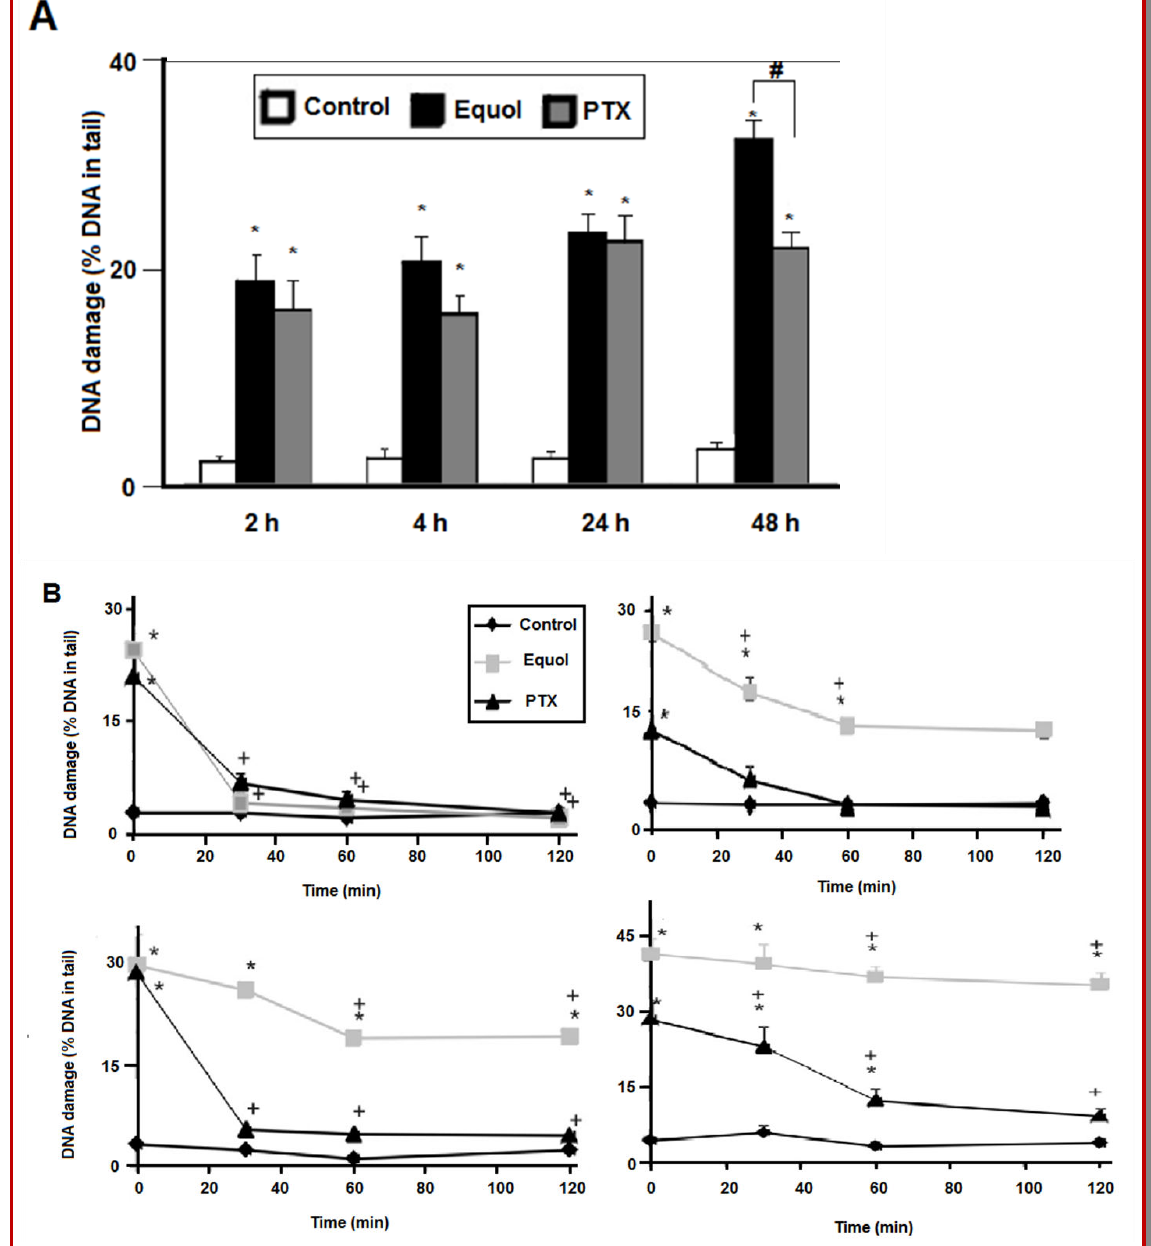
Figure 9 : (A) Mean basal endogenous DNA damage measured as the mean comet tail DNA of control cells (without visual disturb- ances) which were treated with IC 50 concentration of equol and PTX. The number of analyzed cells in each treatment was 100, and the analysis was repeated four times. (B) Representative kinetics of DNA damage repair in SKOV-3 cells. DNA damage was in- duced by incubation with IC 50 concentration of equol and PTX for (1) 2 hours, (2) 4 hours, (3) 24 hours and (4) 48 hours. Repair incubation was in a fresh medium after washing out drugs for 30, 60 and 120 min. Error bars denote